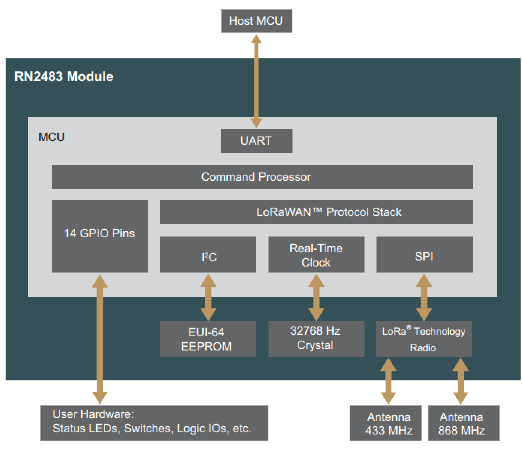
Figure 6. RN2483 Block